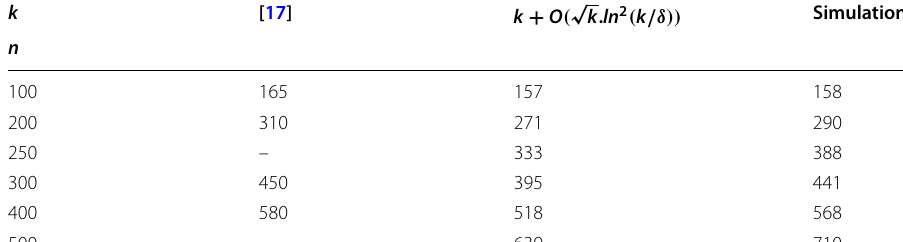
Table 1 Required number of encoding symbols for successful decoding